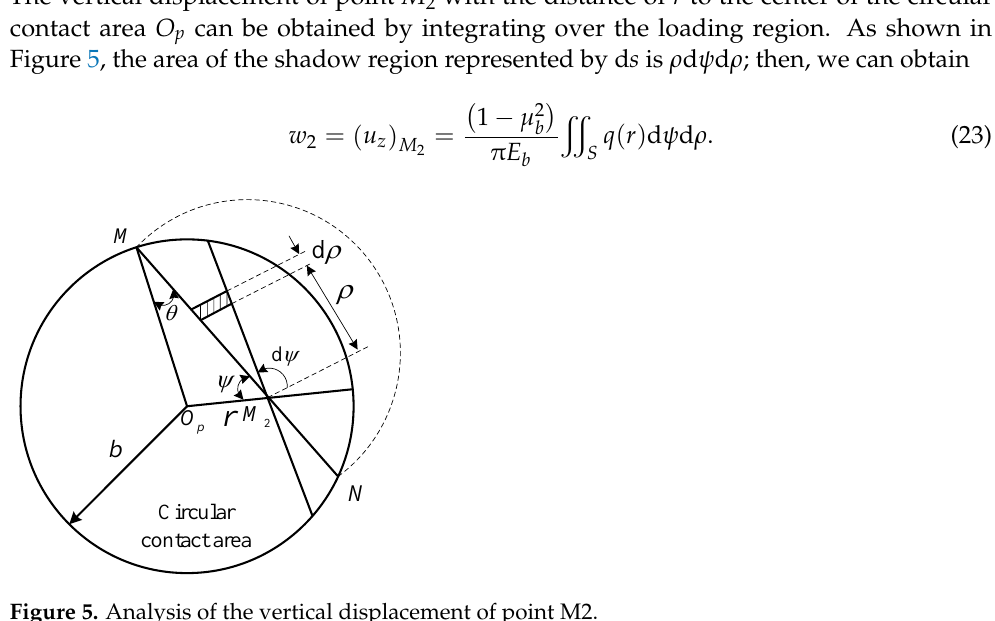
Figure 5. Analysis of the vertical displacement of point M2.